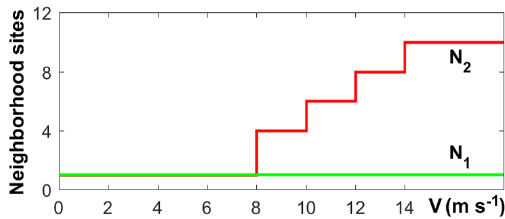
Figure 5. The baseline fire spread rule ( N 1 ) and the new wind prop- agation rule ( N 2